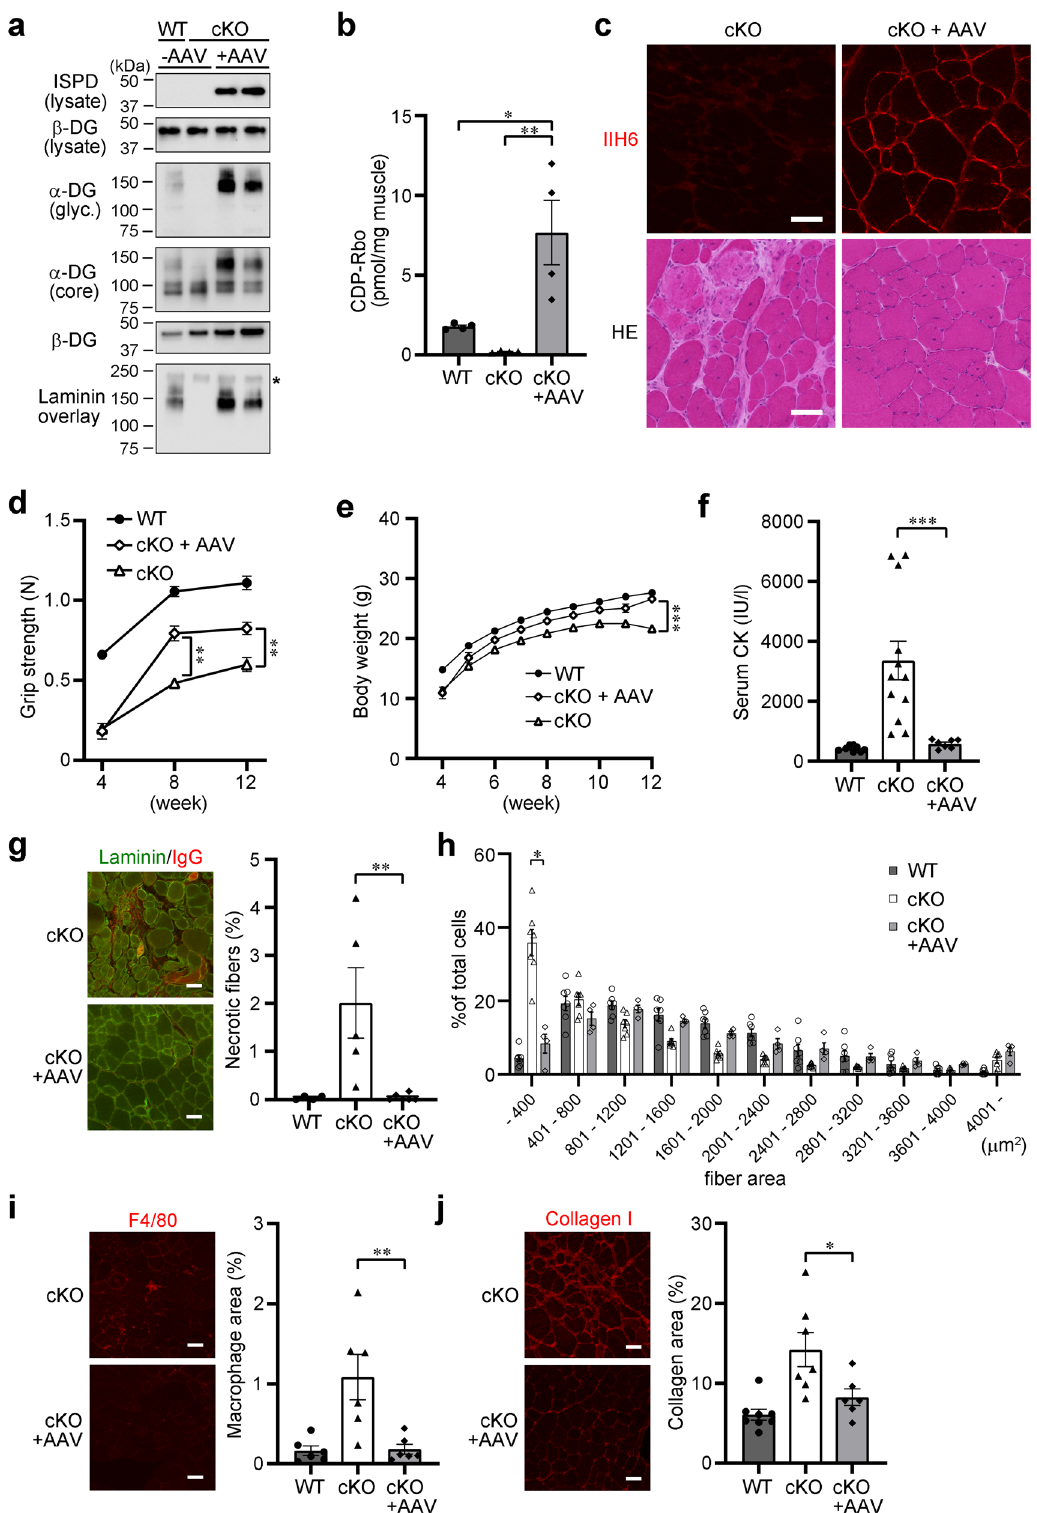
chemistry of CDP-Rbo derivatives, we use simpli fi ed abbreviations here; for example, CDP(DiA)-Rbo represents the diacetyl modi fi ca- tion on the ribose moiety of CDP and CDP-Rbo(TetA) represents the tetraacetyl modi fi cation on the ribitol moiety (Table 1 and Supplementary Fig. 4). The activities of these CDP-Rbo derivatives were evaluated by testing the restoration of α -DG glycosylation in ISPD -de fi cient HEK293 cells.